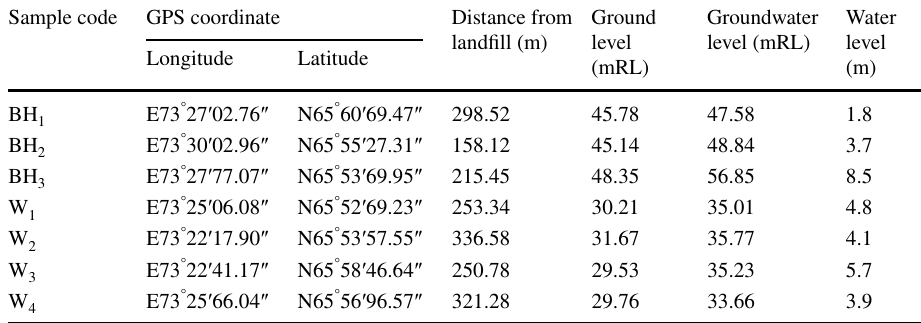
mRL mean reduced